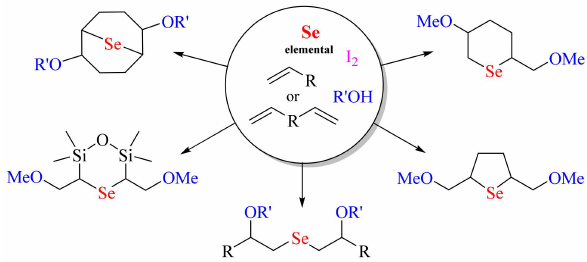
Figure 6. Synthesized linear and cyclic